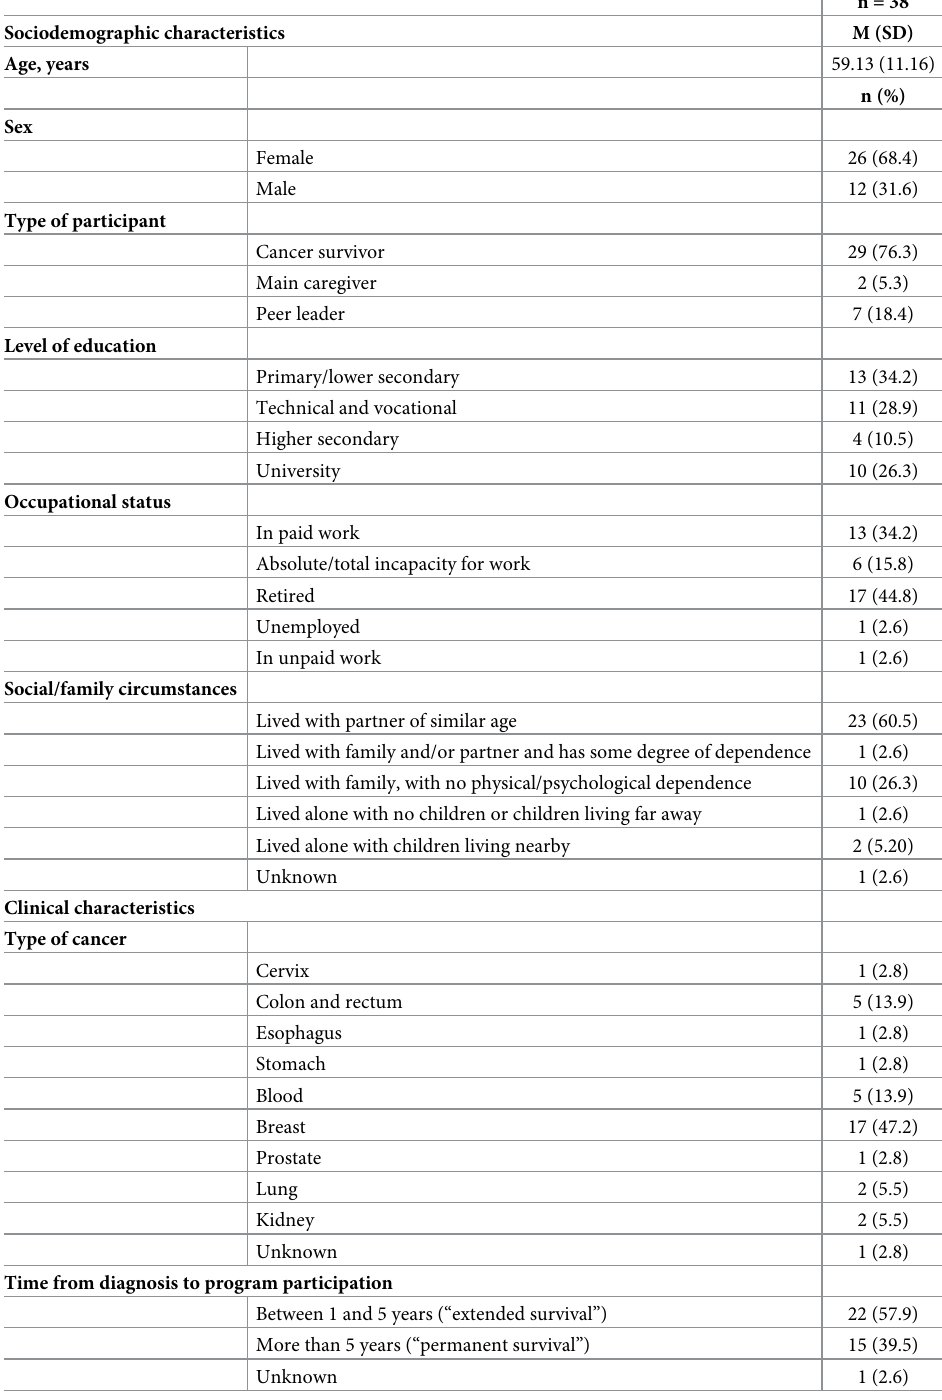
Table 2. Sociodemographic and clinical characteristics of